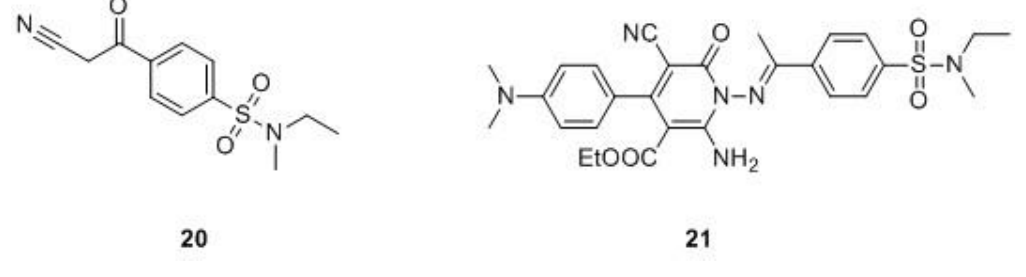
Figure 10. Recent hDHFR inhibitors.